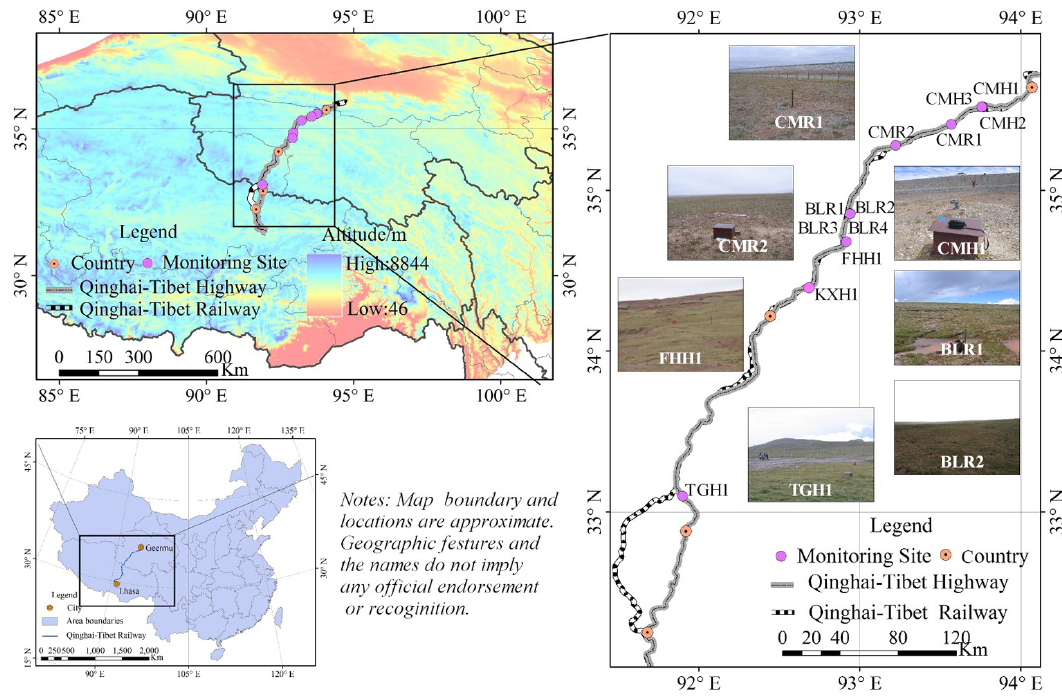
Figure 1. Geographic locations of 12 monitoring sites. Table 1. Information on 12 monitoring sites along QTH and